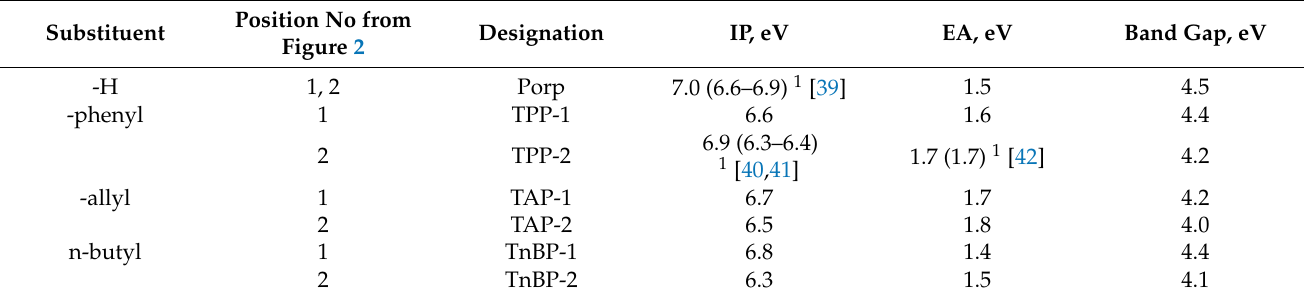
Table 3. Effects of substituents and their positions in the porphine ring on adiabatic IP, adiabatic EA, and the band